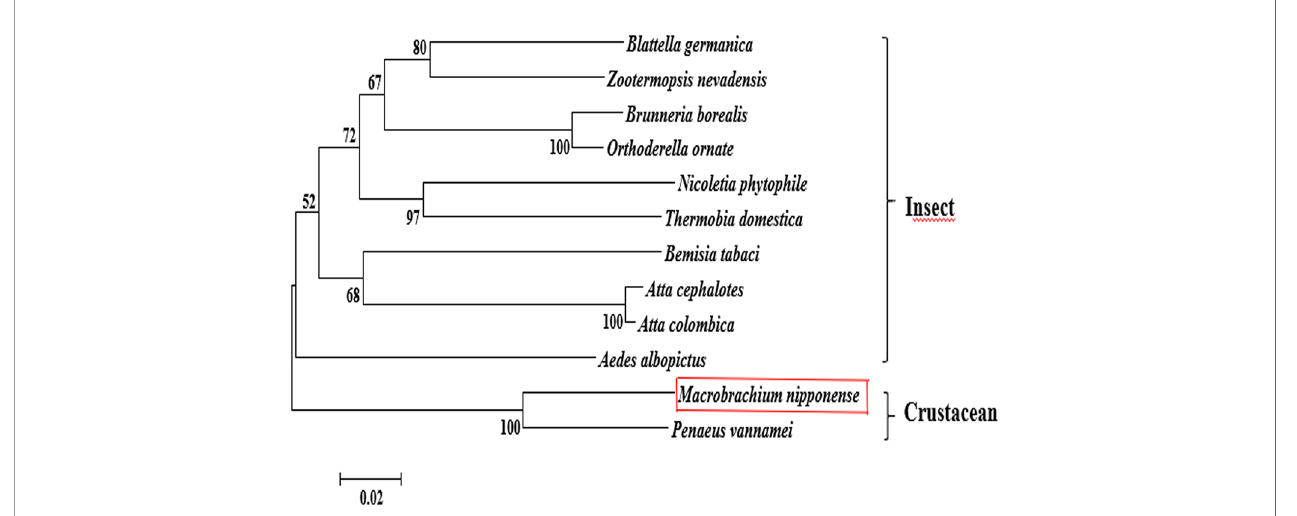
FIGURE 3 | The phylogenetic tree of PDHE1 from different organisms based on amino acid sequence comparisons. Species names and types of PDHE1 are listed on the right of the tree. Red rectangles indicated M. nipponense